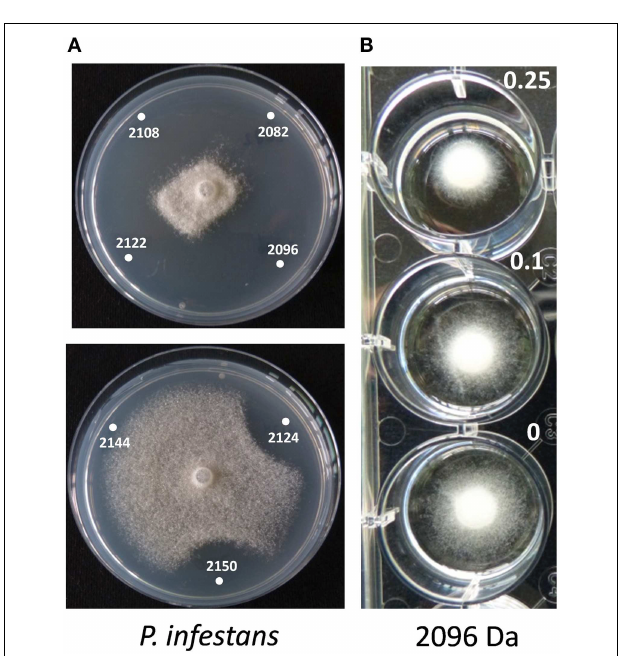
FIGURE 7 | Activity of thanapeptin derivatives against Phytophthora infestans . (A) Activity of thanapeptin tested on plate. Numbers indicated in the pictures are the parent mass of the derivate tested in Da. (B) For the derivate of 2096 Da the growth-inhibitory activity was tested in liquid broth, at different concentrations, indicated in the picture in µ